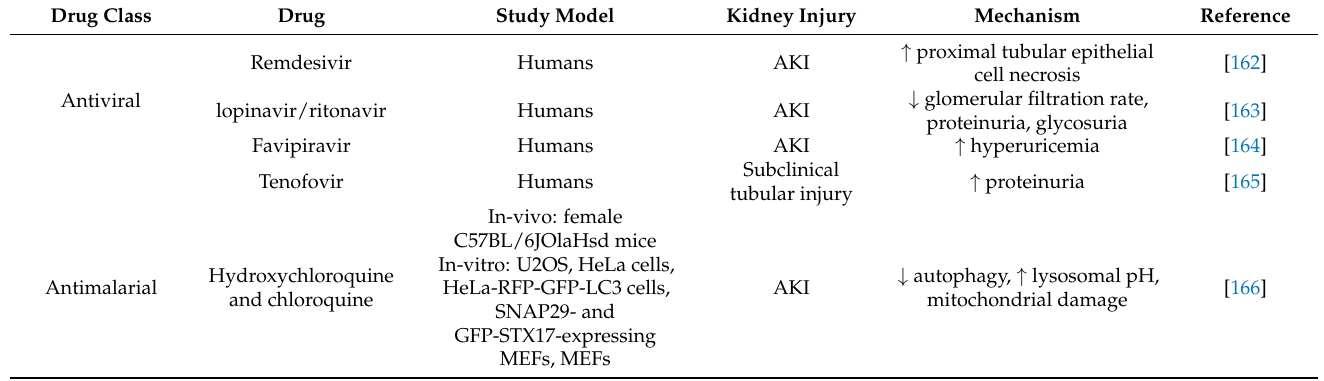
Table 1. COVID-19 drugs causing kidney